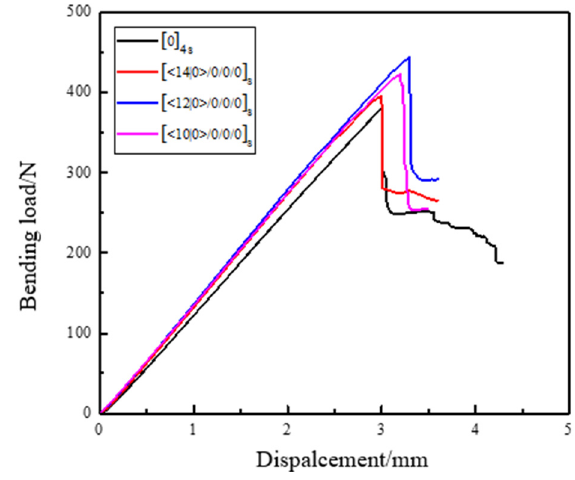
Figure 12. The curved load–displacement curve of a linear and curved specimen. Table 2. The bending strength of different geodesic curvature curve layers and 0 ◦ linear layer